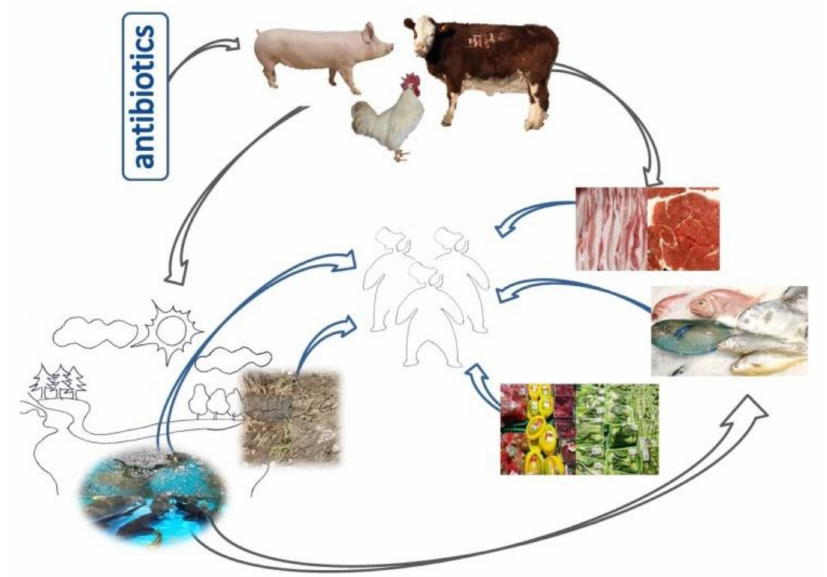
Figure 1. Veterinary antibiotics are widely used in the livestock and poultry production industry to accelerate the growth of livestock and poultry and treat diseases. This has led to the extensive spread of AMR and ARGs from animals to people, other animals, plants, the ecosystem, and the environment (soil and water pollution), as illustrated in this schematic